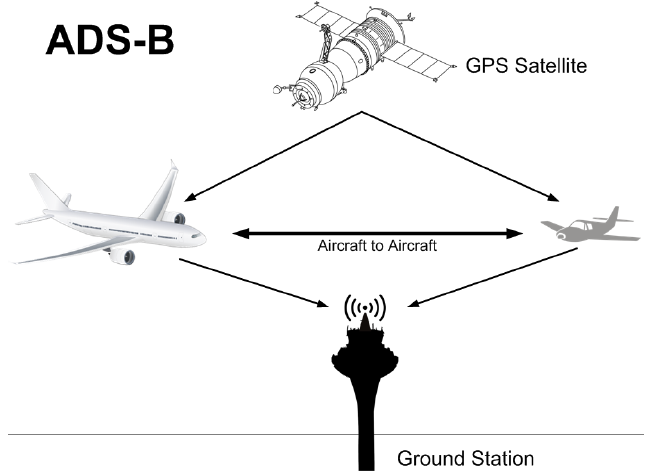
Figure 1. Standard ADS-B (Automatic Dependent Surveillance-Broadcast) operation.